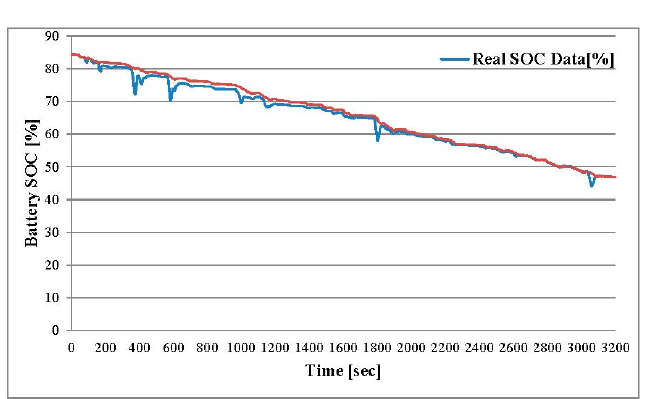
Figure 11. Simulated SOC trace.